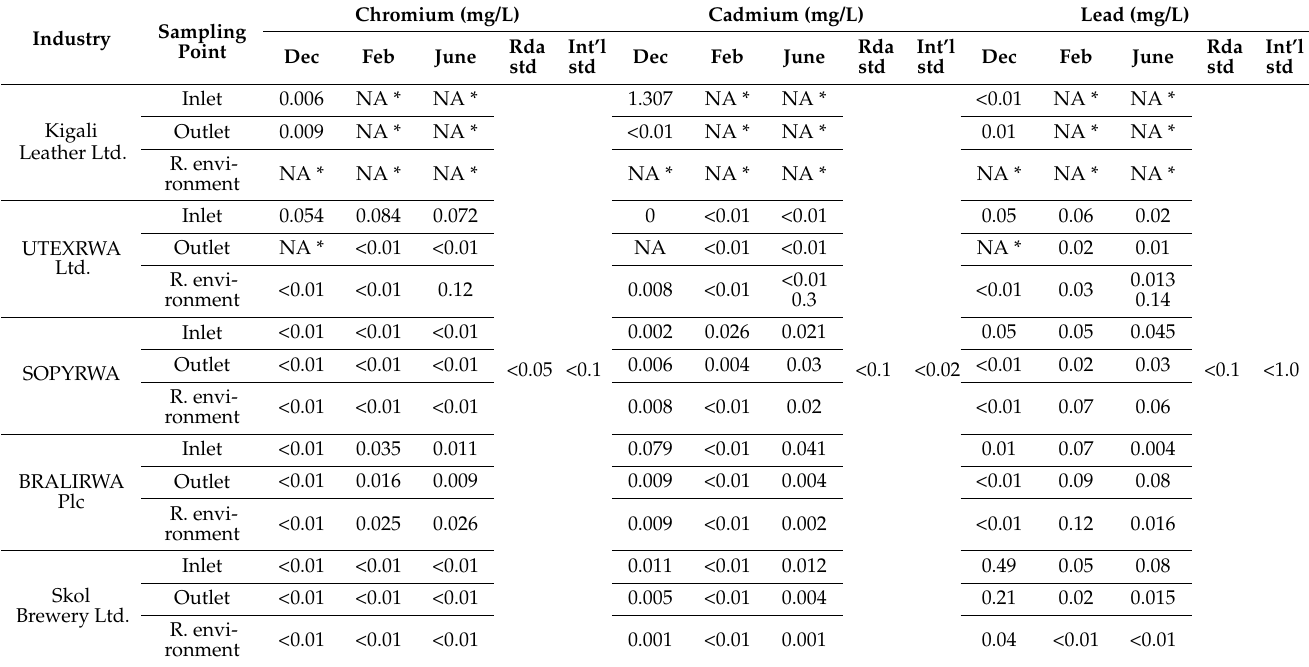
Table 7. Heavy metal results for the selected industries.